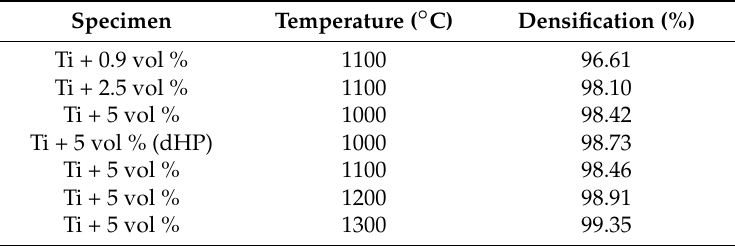
Table 3. Densification values of processed TMCs.